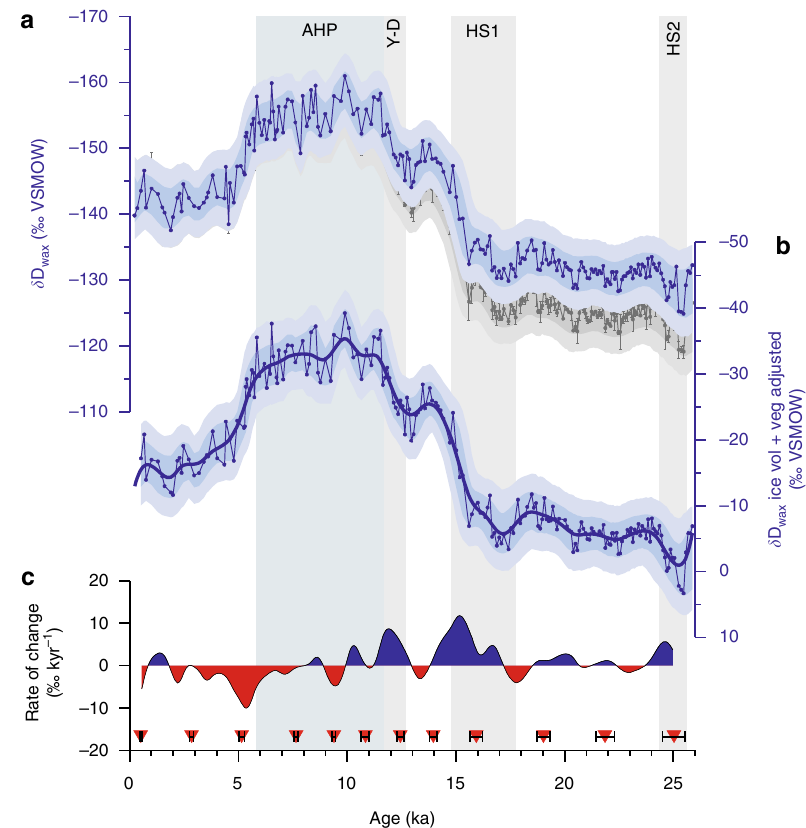
Fig. 3 δ D wax from core GeoB4905-4 in the Gulf of Guinea. a Grey timeseries represents unadjusted δ D wax . Error bars are individual analytical uncertainty. Shadings indicate 68 and 95% uncertainty bounds, including a mean analytical uncertainty of 3 ‰ and age uncertainty. Blue timeseries represents δ D wax adjusted for ice volume, shading as above. b δ D wax adjusted for ice-volume and vegetation-type changes, representing an estimate of past δ D p . Shadings as above. Thick black line is the Ruppert-Sheather-Wand smooth, the optimal smoothing for the data set 86 . c Rate of change ( ‰ kyr − 1 ) based on Ruppert- Sheather-Wand smooth. Blue colours representing periods of wettening, red represent periods of aridi fi cation. Red diamonds mark calibrated radiocarbon age control points. Vertical bars highlight the African Humid Period (AHP), Younger-Dryas (Y-D) and Heinrich Stadials 1 and 2 (HS1,